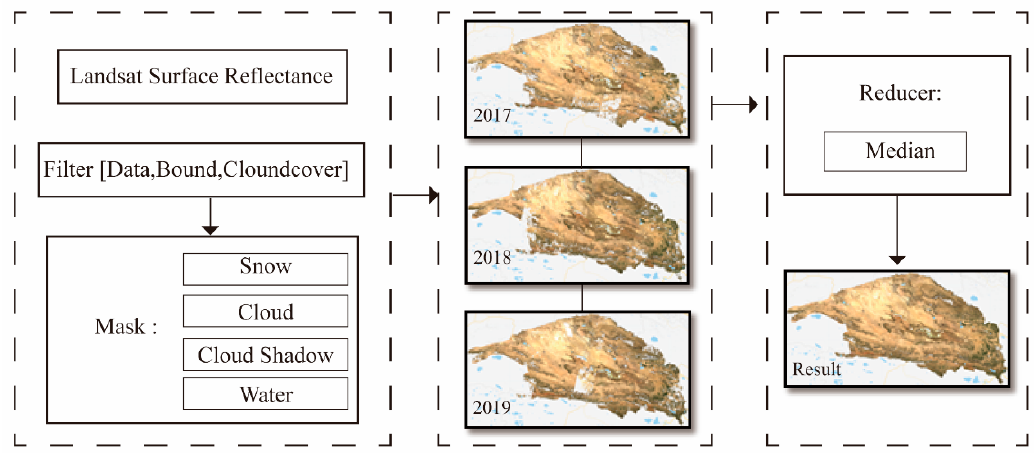
Figure 3. Flowchart of remote sensing image preprocess in Qaidam Basin on GEE.